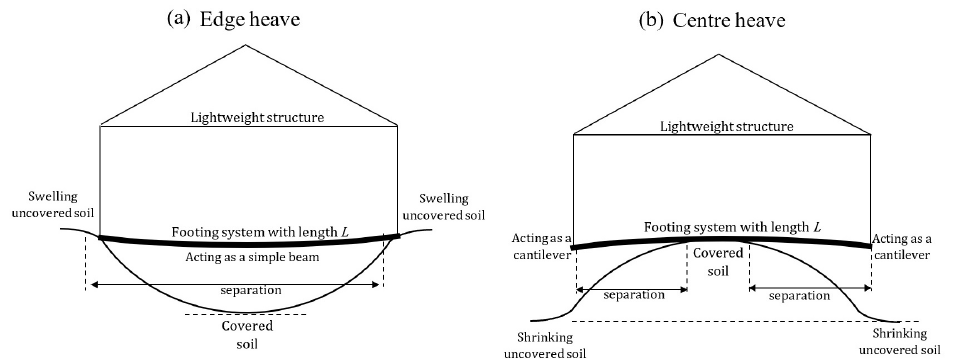
Figure 1. Two cases of reactive soil heaving: ( a ) edge heaving due to the swelling uncovered ground, and ( b ) centre heaving due to the shrinking uncovered